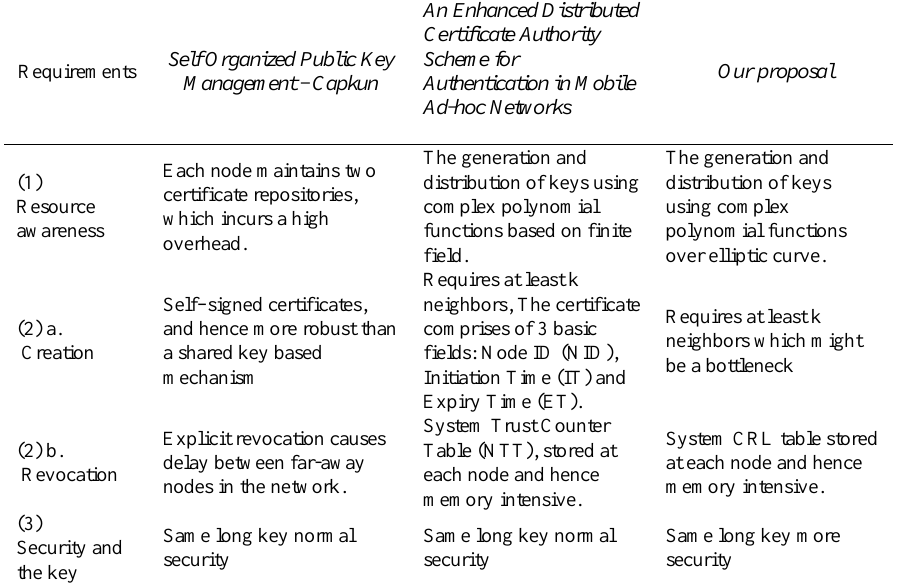
Table 1: Comparison of Certificate-distribution